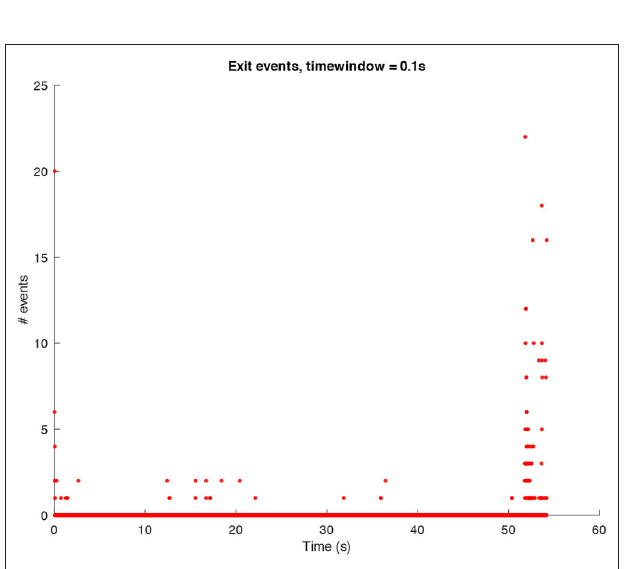
FIGURE 2 | Amount of exit events per window of time (0.1 s ) in a shutdown process.